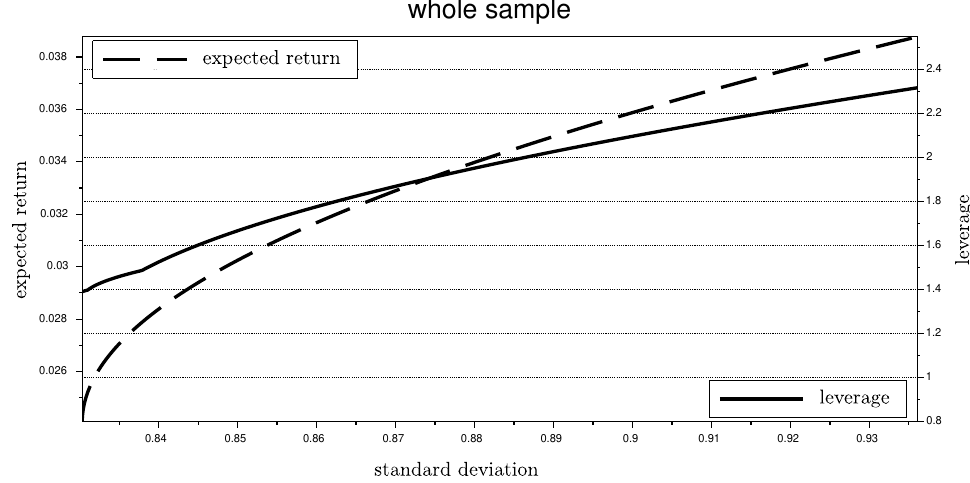
Figure 1. Leverage (solid) of the classical frontier portfolios (dashed). Data: SPX level 1 sectors, from 1990 to 2018. For a detailed data description see Section